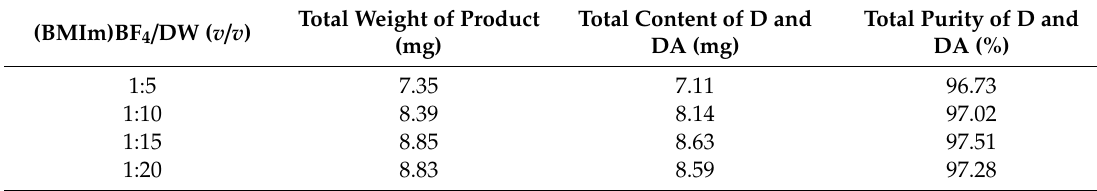
Table 8. Total Purity of D and DA in the